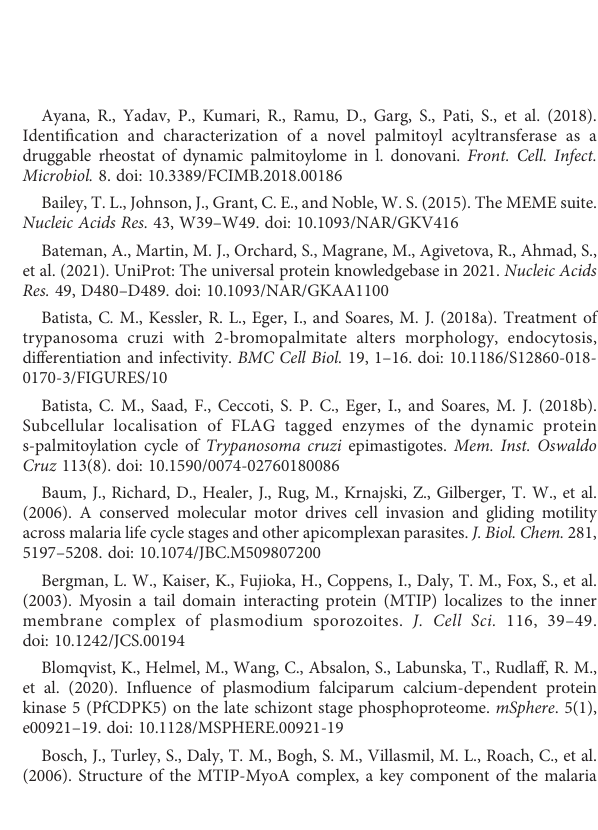
SUPPLEMENTARY TABLE 3 Cumulative palmitome of Plasmodium falciparum 3D7. SUPPLEMENTARY TABLE 4 A list of all the PTM events and sites pertaining to Plasmodium falciparum 3D7 proteome. SUPPLEMENTARY TABLE 5 Consensus palmitoylation and phosphorylation sequence windows discovered using the MoMo web interface along with the sequence logo graphs. SUPPLEMENTARY TABLE 6 A catalog of all the “ Dually Modi fi able ” and “ Dually Modi fi ed ” Plasmodium falciparum 3D7 proteins. SUPPLEMENTARY TABLE 7 The results generated from the k-means clustering of the dually modi fi able Plasmodium falciparum 3D7 proteins. SUPPLEMENTARY TABLE 8 PTM hotspot regions in all the modi fi able proteins acquired from curated datasets/databases and prediction results, including PTM events and hotspots distribution on dually modi fi ed Plasmodium falciparum 3D7 proteins essential for its survival. SUPPLEMENTARY TABLE 9 A tabular representation of the physical PPI map constituting